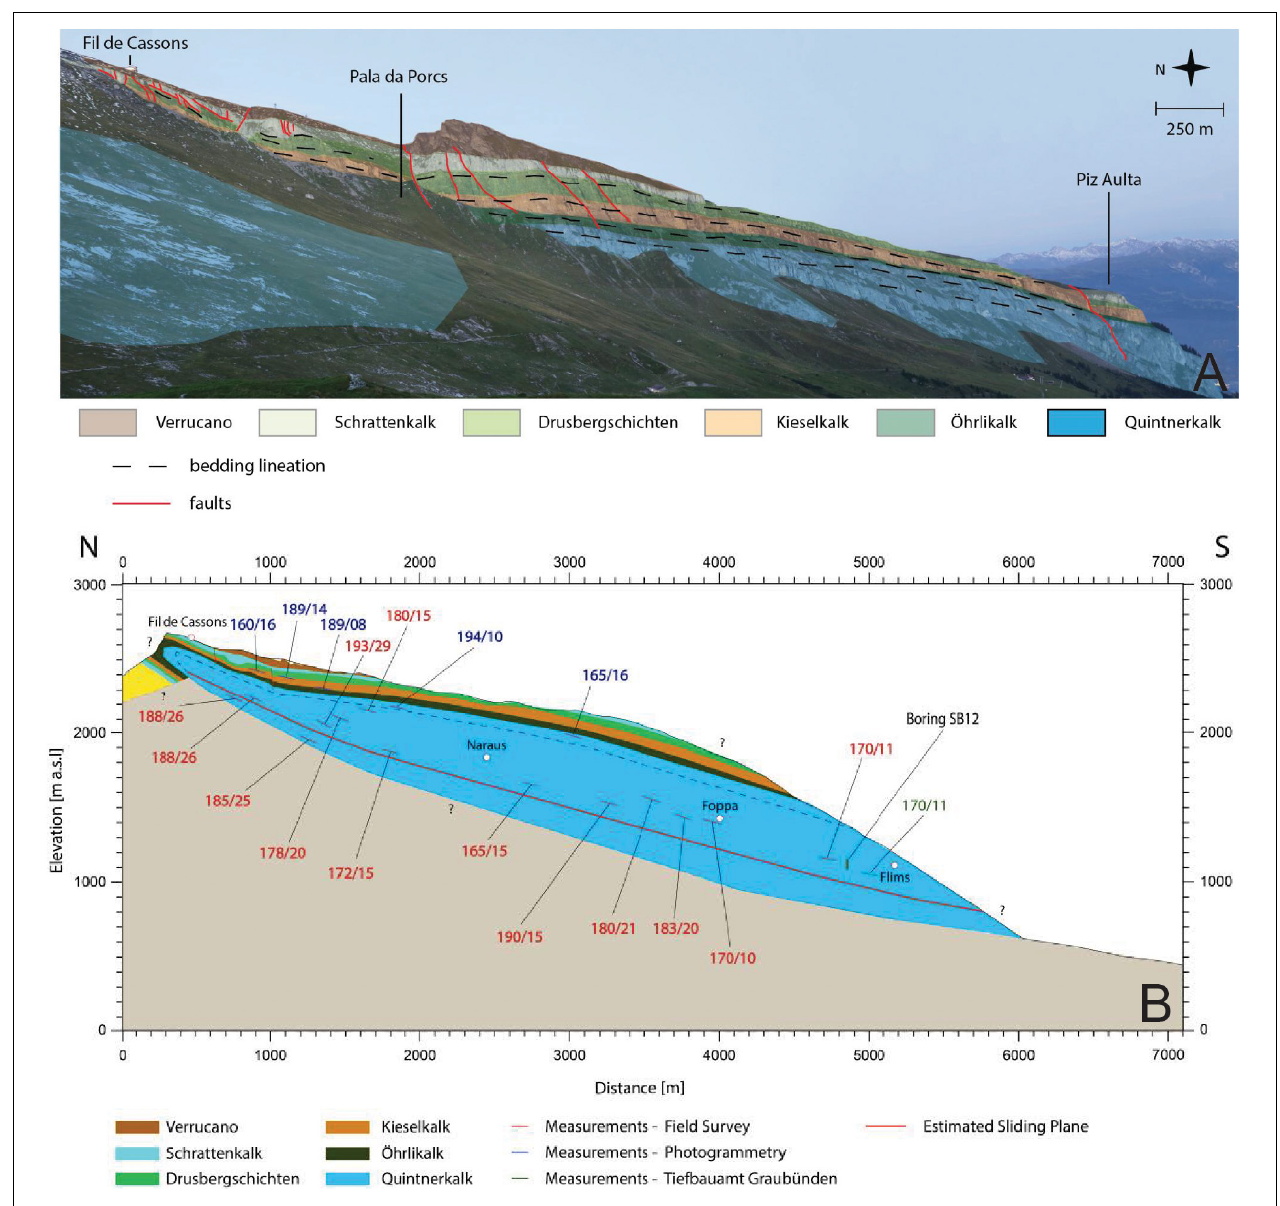
FIGURE 3 | Top: Image of the side scarp, showing site stratigraphy and steep faulting. The location of where this image was taken is shown on Figure 2 . Bottom: Reconstructed geological profile with bedding plane orientations; the section line is shown on Figure 4 .